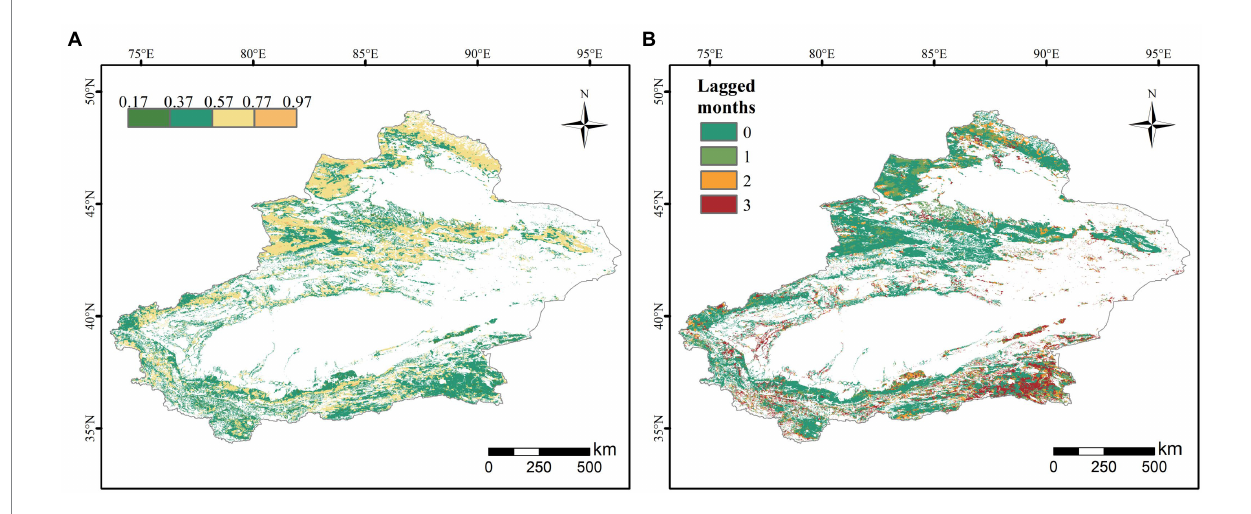
FIGURE 11 (A) Spatial distributions of the r max-lag between the SPEI and NPP during 1982–2020. (B) Spatial distribution of the corresponding lagged months where the r max-lag